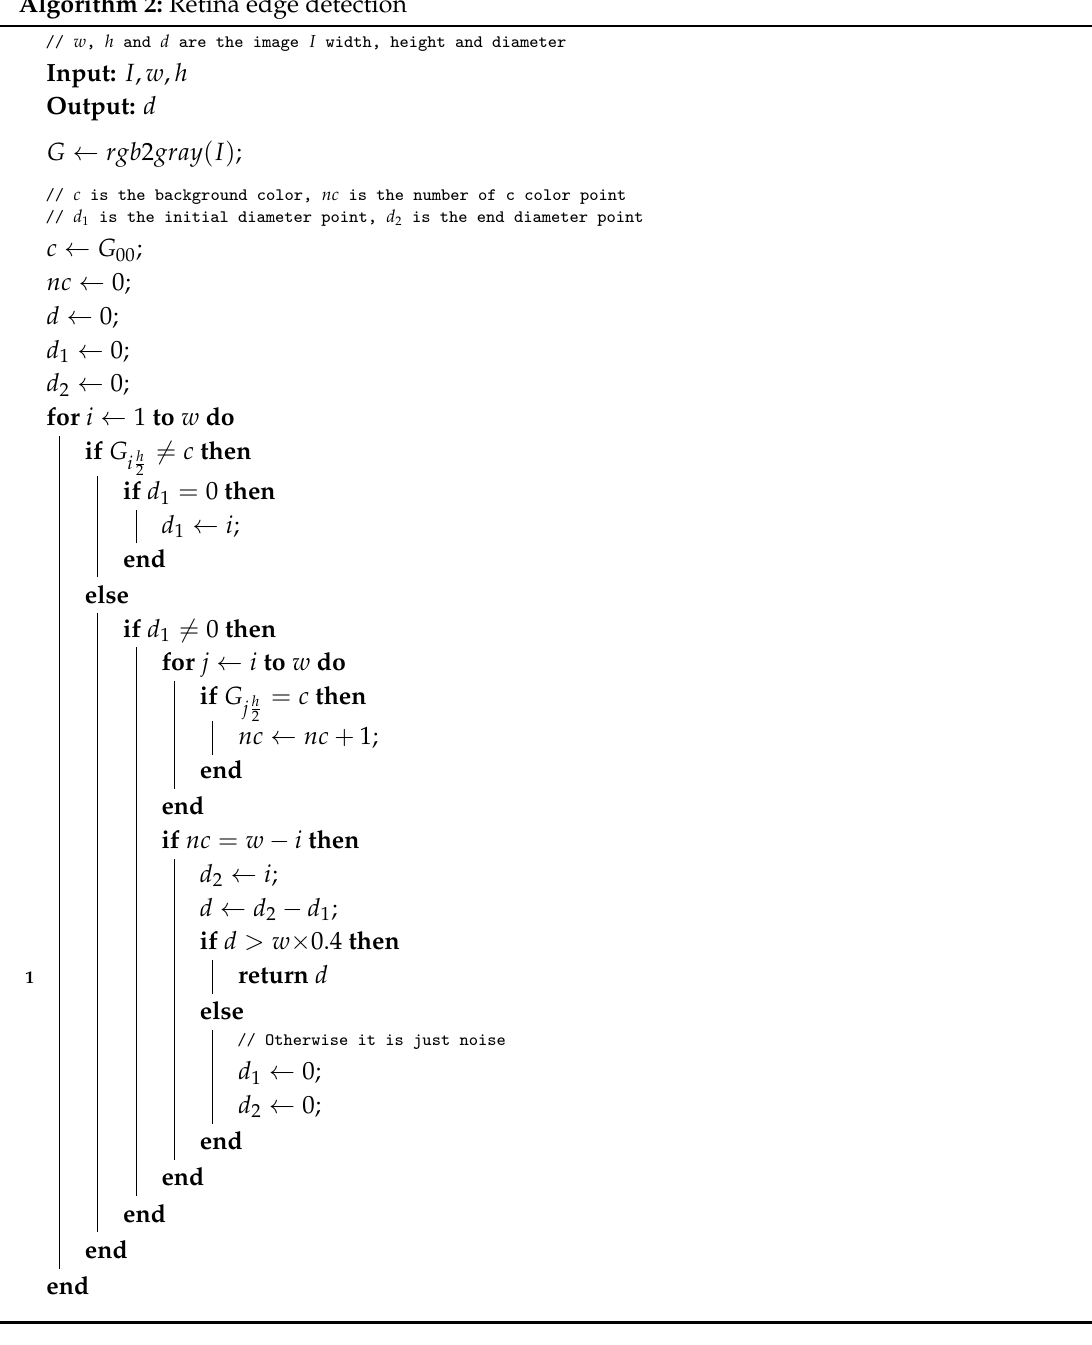
Algorithm 2: Retina edge